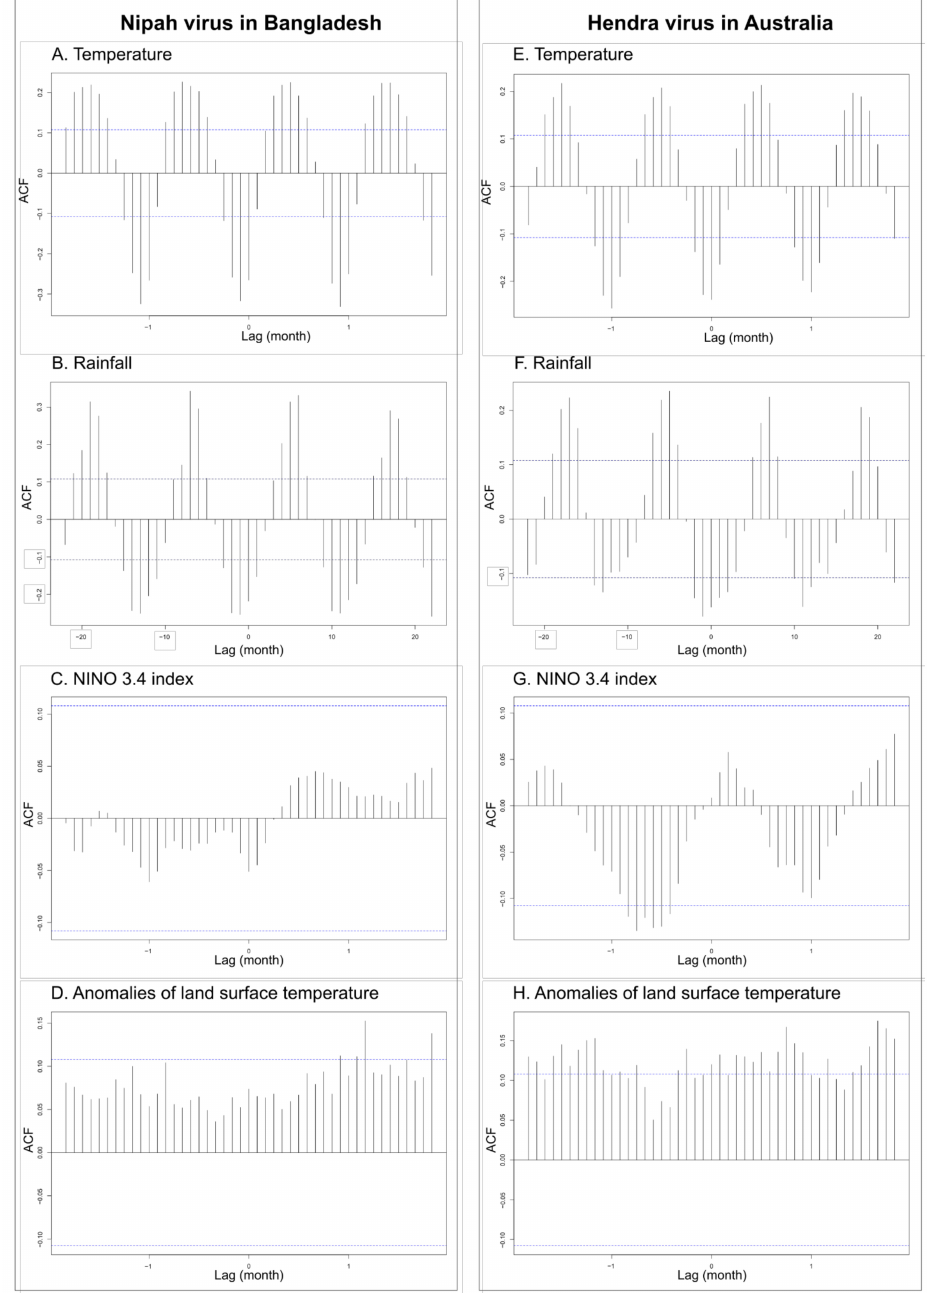
Figure 3. Temporal correlation from January 1993 to June 2020 (330 months) with significant auto- correlation values in dashed lines between spillover events of the Nipah virus in Bangladesh and the Hendra virus in Australia, as well as the monthly temperature ( A , E ), the monthly rainfall ( B , F ), the NINO 3.4 index ( C , G ), and anomalies of the land surface temperature ( D , H